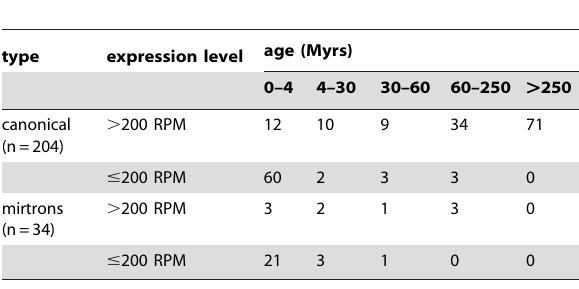
Table 1. Number of miRNAs in the genome of D. melanogaster in different age